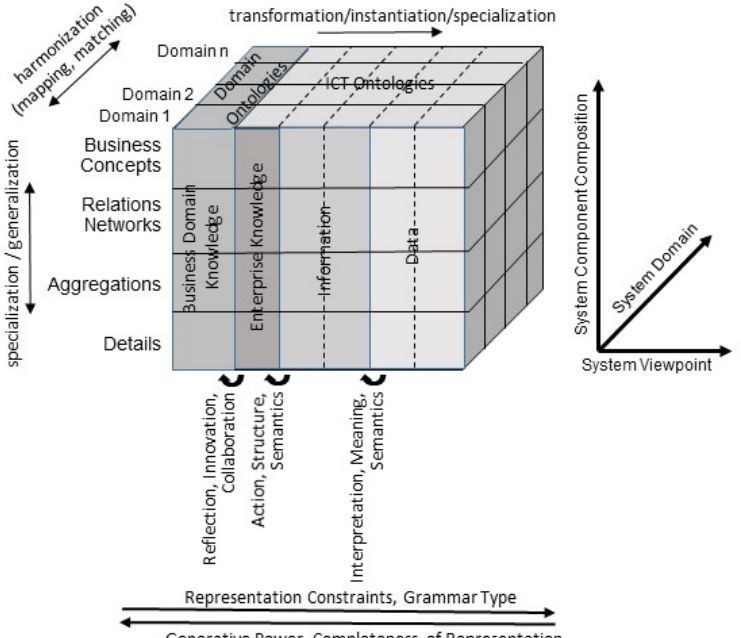
Figure 7. Generic business system representation according to ISO 23903 from the perspective of the knowledge pyramid after Aamodt and Nygard [46] and the model hierarchy after Krogstie [45].